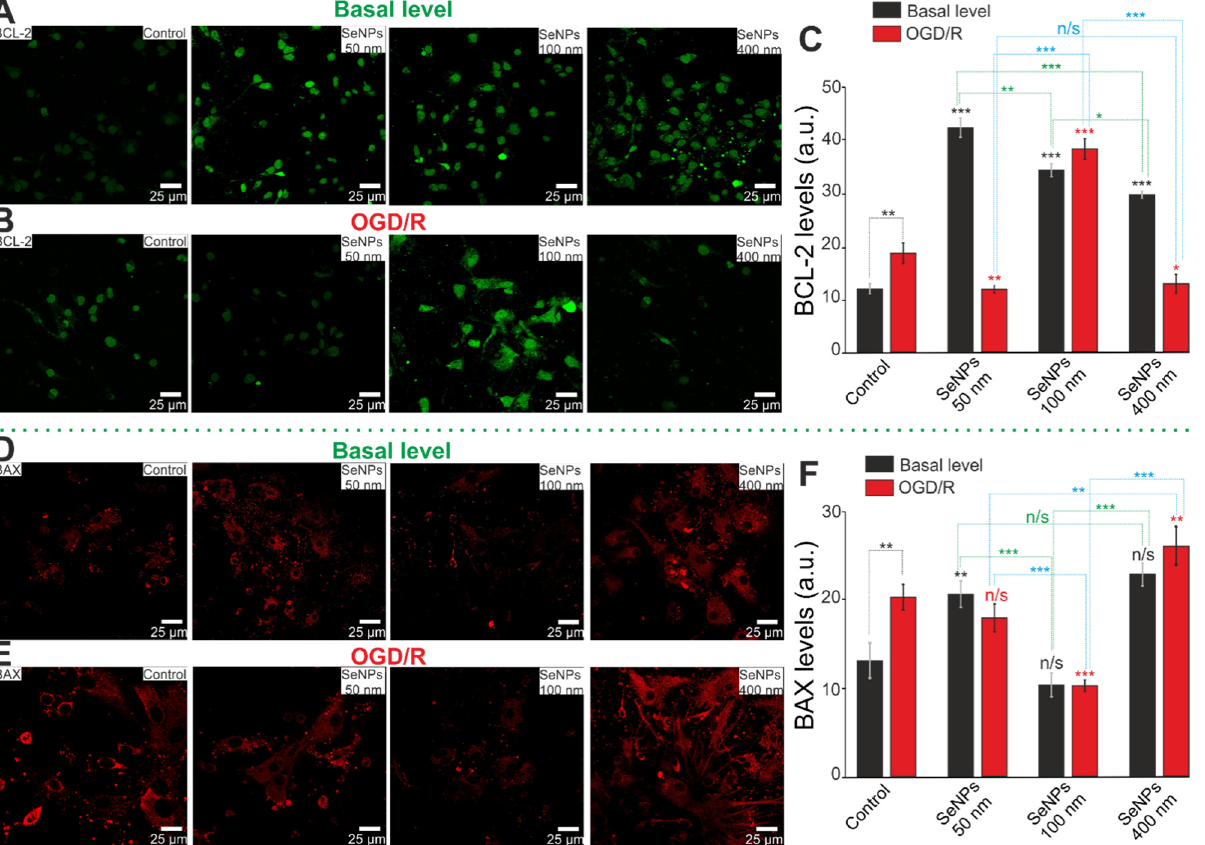
Figure 10. Immunocytochemical staining of cortical cell culture with antibodies against BCL-2 ( A , B ) and BAX ( D , E ), regulators of apoptosis, after 24-h incubation with 3 μ g/mL of different-sized SeNPs without OGD/R ( A , D ) and 24 h after OGD/R ( B , E ). ( C , F )—Intensity levels of BCL-2 ( C ) and BAX ( F ) were determined by confocal imaging. We analyzed individual cells that had fluorescence of secondary antibodies. The quantative data reflecting the level of BCL-2 or BAX expression are presented as fluorescence intensity values in summary bar charts (mean ± SEM). The values were averaged by 150 cells for each column. The results obtained after immunostaining agree with the data of fluorescence presented in panels ( A , B , D , E ). Each value is the mean ± SE ( n ≥ 3, p < 0.05). Statistical significance was assessed using paired t -test. Black asterisks represent comparison of baseline expression levels after incubation with different sized nanoparticles versus control. Red asterisks represent comparison of expression level after incubation with different-sized SeNPs versus OGD/R-induced levels; n/s—data not significant ( p > 0.05), * p < 0.05, ** p < 0.01, *** p < 0.001. After OGD/R and incubation with SeNPs (50 nm), the expression of 4 genes